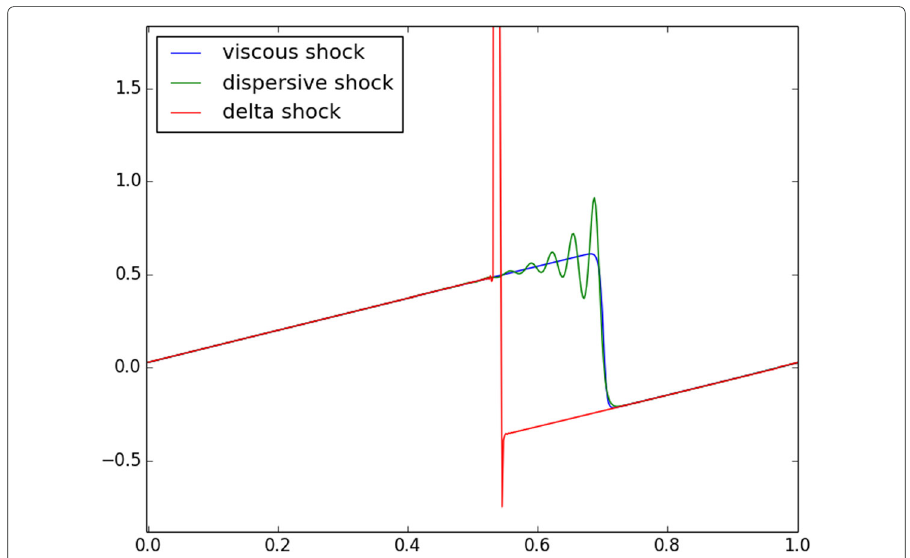
Fig. 1 Shocks in Burgers’ equation. (Color online) Various types of shocks resulting from different regularizations of the Hopf equation: viscous shock (blue), dispersive shock (green), and delta shock